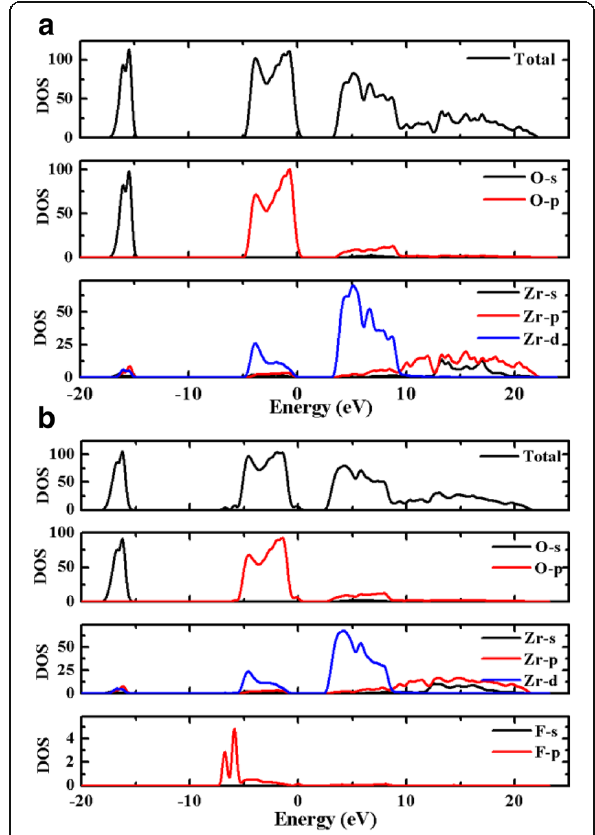
Fig. 4 The calculated total density of states (TDOS) and partial density of states (PDOS) for the samples without CHF 3 treatment ( a ) and with